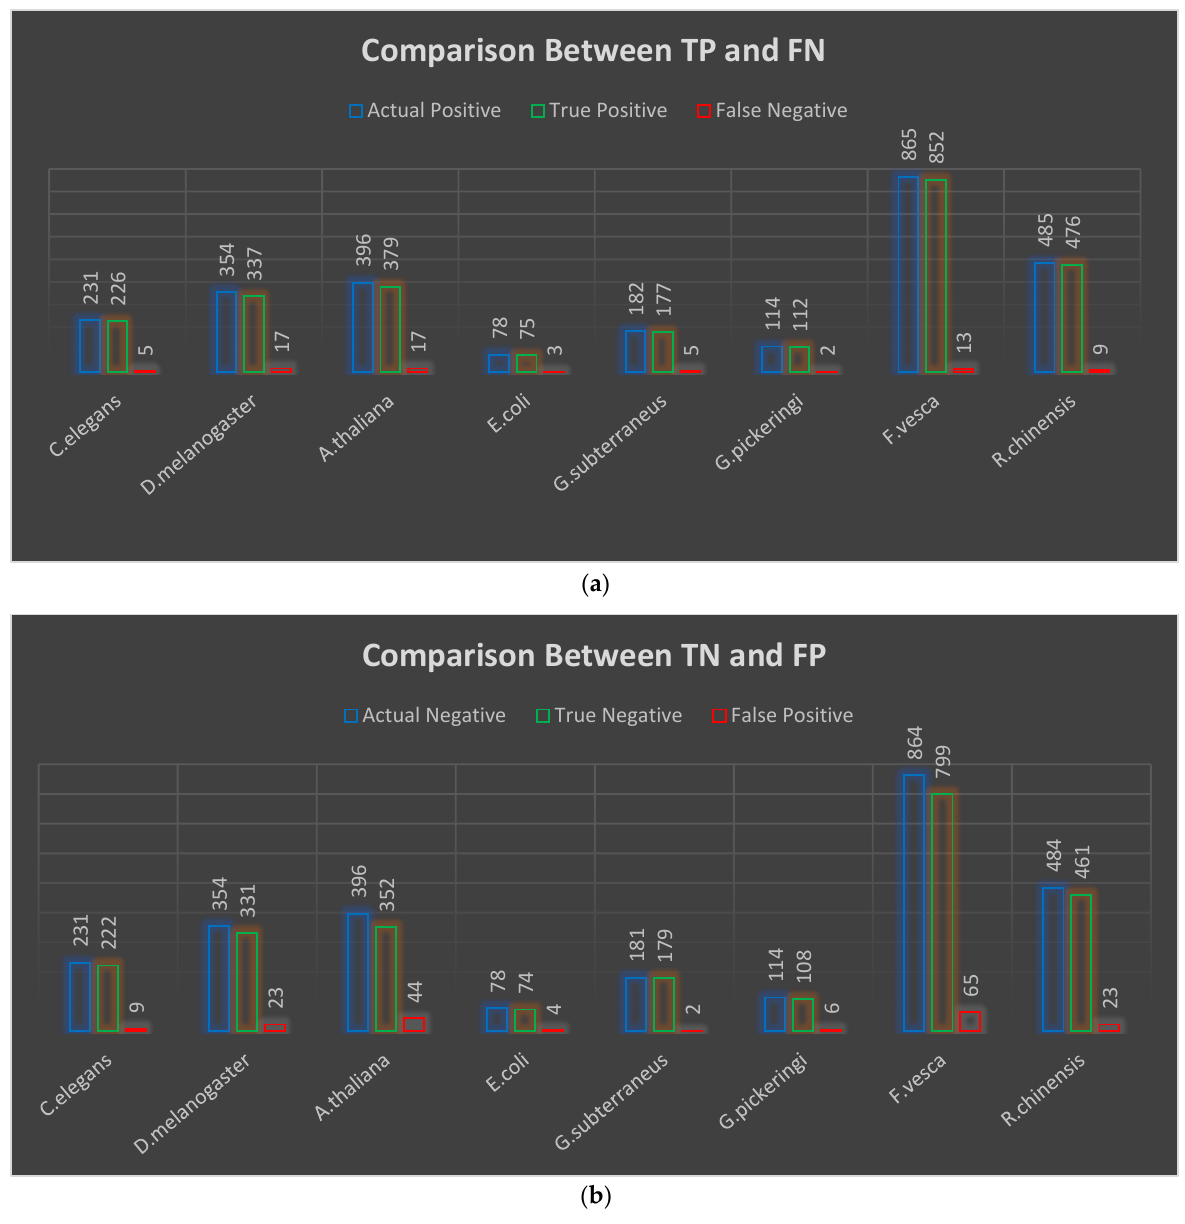
Figure 2. ( a ) Comparison between TP and FN, ( b ) Comparison between TN and FP. True positive and true negative are represented as TP and TN in Figure 2a,b above, with the correct number of identified sequences related to 4mC and non-4mC, respectively. False positive and false negative denoted are as FP and FN, respectively, and indicate the false number of identified sequences for 4mC and non-4mC. We have split each dataset 80:20, where 80% is the training set and 20% is the testing set. The total number of 4mC sites correctly identified by this proposed model for C. elegans , D. melanogaster , A. thaliana , E. coli , G. subterraneus , G. pickeringi , F. vesca , and R. chinensis datasets are 226 out of 231, 337 out of 354, 379 out of 396, 75 out of 78, 177 out of 182, 112 out of 114, 852 out of 865, and 476 out of 485, respectively. The non-4mC sites correctly identified by this pro- posed model for the same datasets are 222 out of 231, 331 out of 354, 352 out of 396, 74 out of 78, 179 out of 181, 108 out of 114, 799 out of 864, and 461 out of 484, respectively. ROC curves are a tool that aids in the understanding of probabilistic forecasts for binary (two-class) classifications of predictive modeling problems. The ROC curve demonstrates how well a classification model performs at different thresholds. ROC is a probability curve. TPR and FPR are used to plot the ROC curve, with TPR on the y-axis and FPR on the x-axis. Compared to the existing model, the proposed model outperforms it at classifying and testing datasets when the ROC curve has a lower x-axis and a higher y-axis value. The level or measurement of separability is represented by AUC. The entire two-dimensional region from (0, 0) to (1, 1) below the entire ROC is measured by AUC. A model with a higher AUC predicts 0 s as 0 s and 1 s as 1 s more frequently. The AUC ROC values are graphically presented in Figure 3.